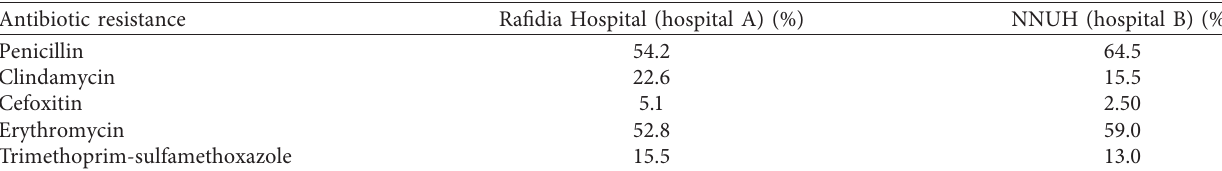
Table 5: Antibiotic resistance of hospital A and B bacterial isolates. Antibiotic resistance